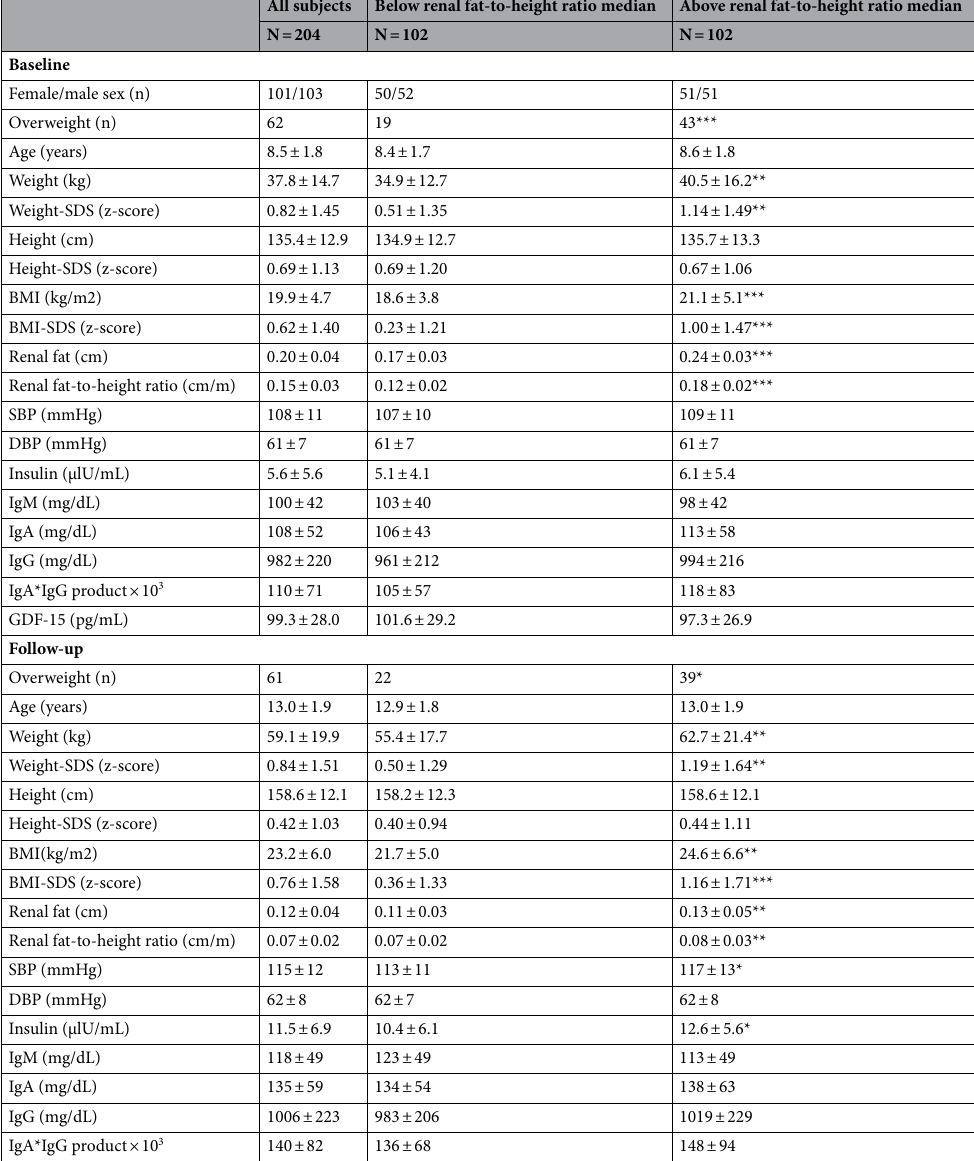
values. SDS standard deviation score, BMI body mass index, SBP systolic blood pressure, DBP diastolic blood pressure, Ig immunoglobulin, GDF-15 growth differentiation factor 15. Independent t-test, *P < 0.05, **P < 0.01, ***P < 0.001 as compared to lower renal fat-to-height ratio median